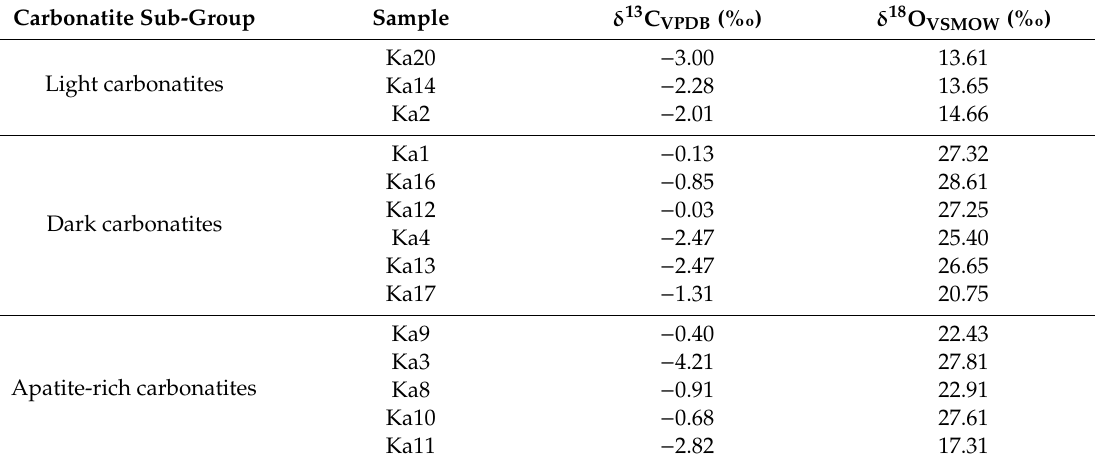
Table A3. Stable C and O isotopic compositions of the Kangankunde carbonatites.